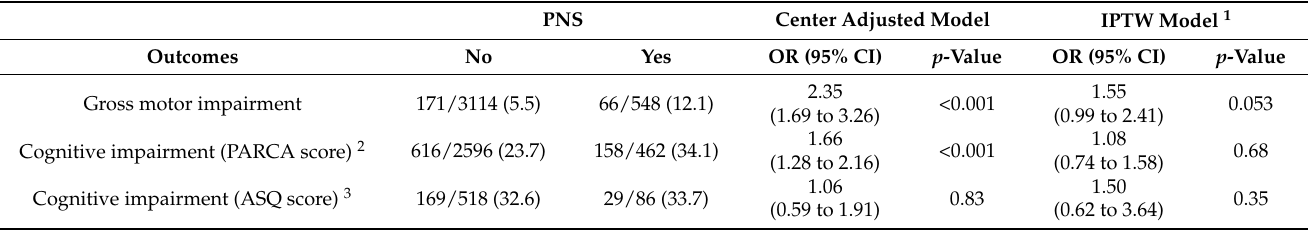
Table 2. Comparison of two-year neurodevelopmental outcomes in PNS and non-PNS treated infants.